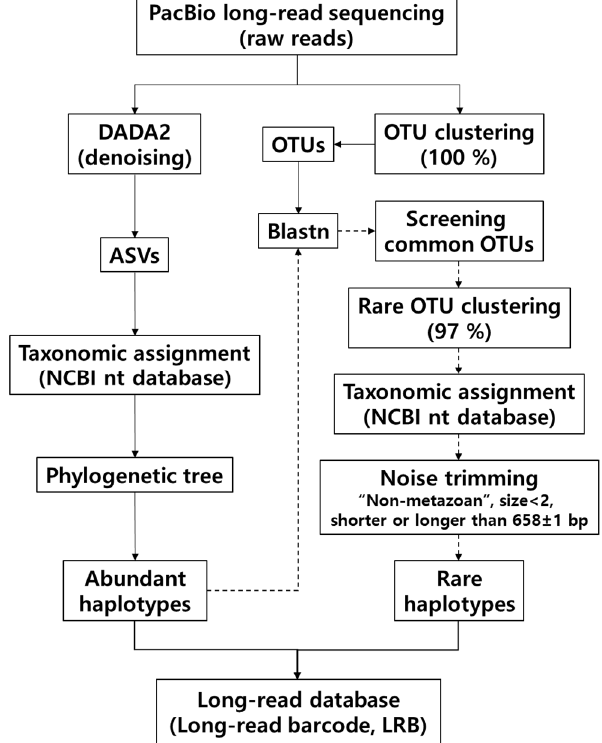
Figure 2. Flow chart of a bioinformatics pipeline for regular barcodes (RBs). The regular-read database was constructed by combining two bioinformatics approaches: denoising and clustering.